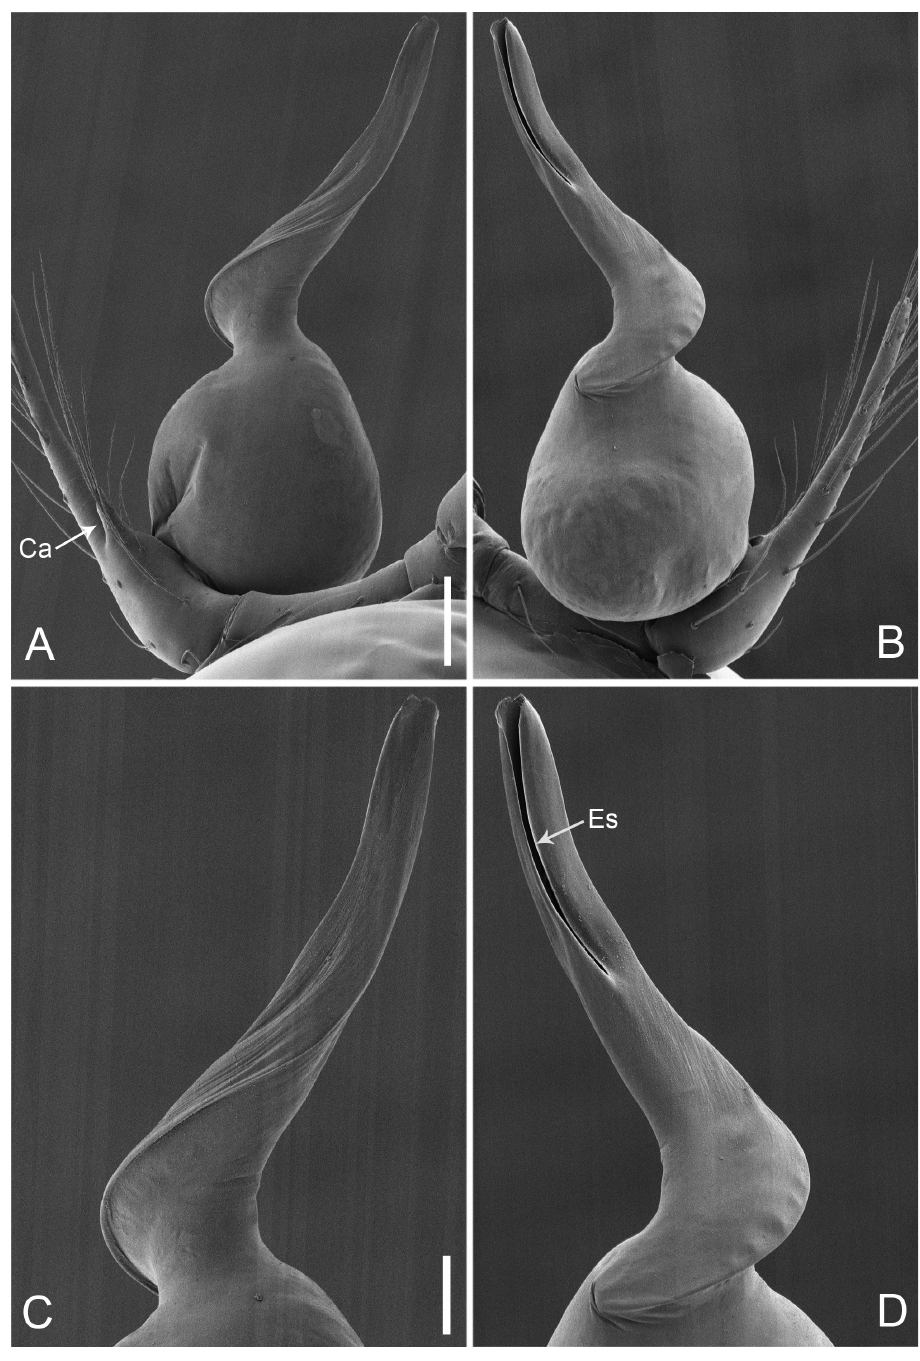
Figure 24. Pinelema xiushuiensis , male. A Palp, prolateral view B Palp, retrolateral view C Embolus, prolateral view D Embolus, retrolateral view. Scale bars: 0.1 mm ( A–B ), 0.05 mm ( C–D